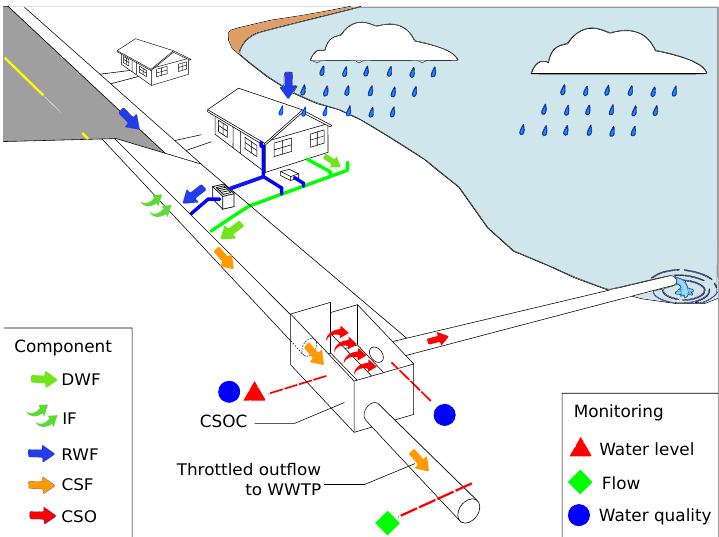
Figure 1. Main components of the EmiStatR model: (1) Dry weather flow (DWF) including infiltration flow (IF), (2) pollution of DWF, (3) rain weather flow (RWF), (4) pollution of RWF, (5) combined sewage flow (CSF) and pollution, and (6) combined sewer overflow (CSO) and pollution. CSOC—CSO chamber (background adapted from Sanitary District